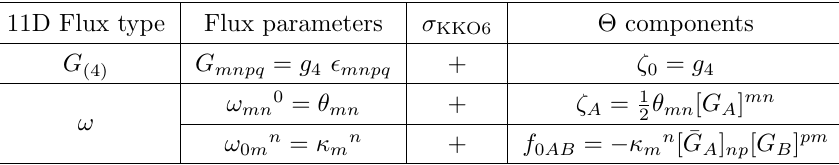
Table 26 . The explicit dictionary between M-theory (cid:13)uxes consistent with the KKO6 involution and deformation parameters of N = (1 ; 1) supergravity in six